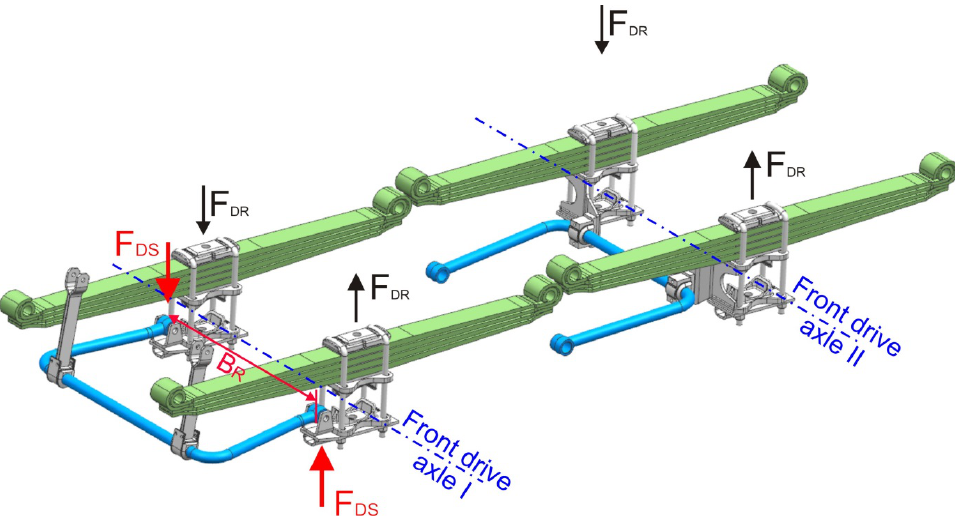
Figure 3. Defined forces of the asymmetric load case in the first and second axle suspension systems